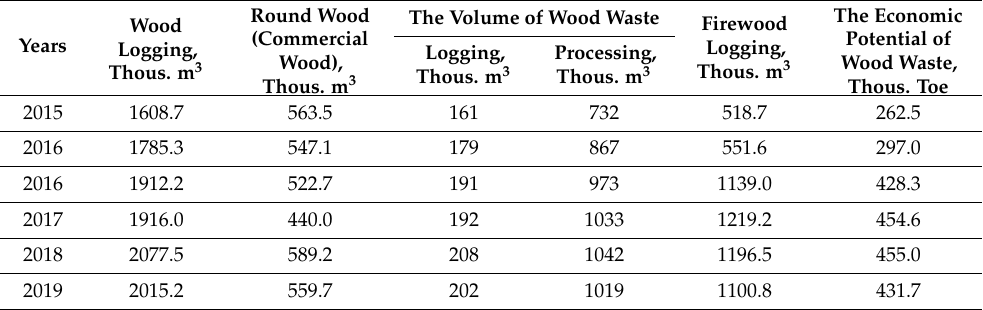
Table 1. The economic potential of wood